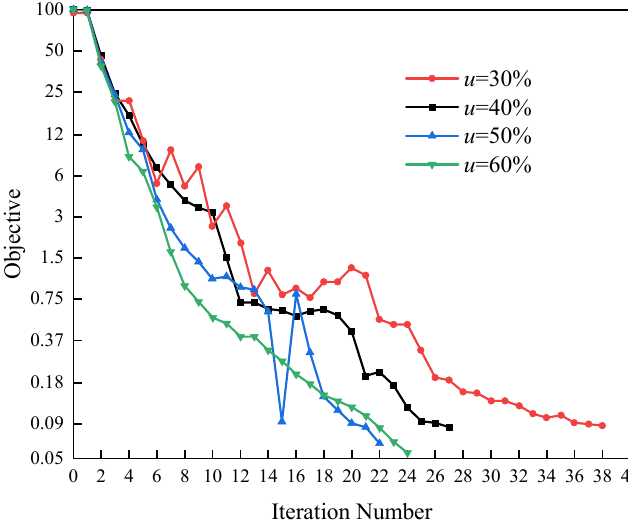
15 of 22 Figure 13. Topology optimization domain. 4.3.2. Optimization Parameters The structural discontinuity problem that easily arises in the calculation process of the SIMP method and the influence of mass retention rate u on the topology optimization results are considered next. The mass retention rate as a design variable, if set too small, will make the topology optimized model distorted into a discontinuity to lose the optimi- zation meaning, although it will achieve the effect of mass reduction. As such. the mass retention rate should be finally determined through multiple simulations and compari- sons. In order to obtain a better material topology configuration, the mass retention rate u is set to 60%, 50%, 40% and 30% of the original valve motion components, and the optimi- zation goal is the maximum overall structural stiffness. The OC optimization criterion is chosen and the convergence tolerance is defined as 0.0001. 4.3.3. Optimization Calculations